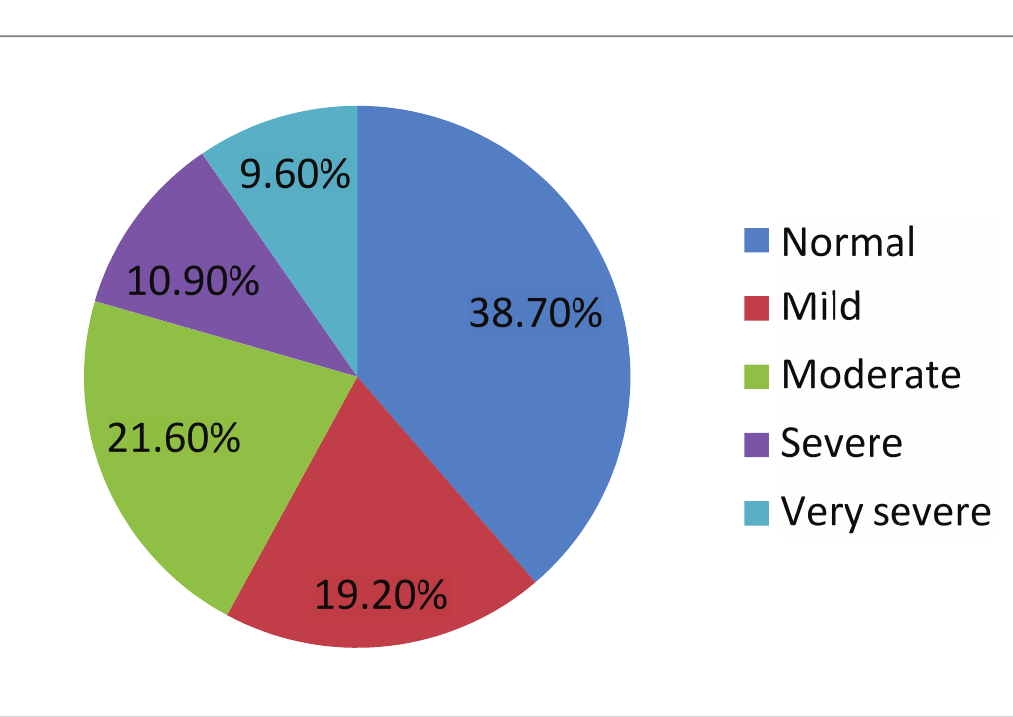
Figure 1 : Prevalence of SAD among